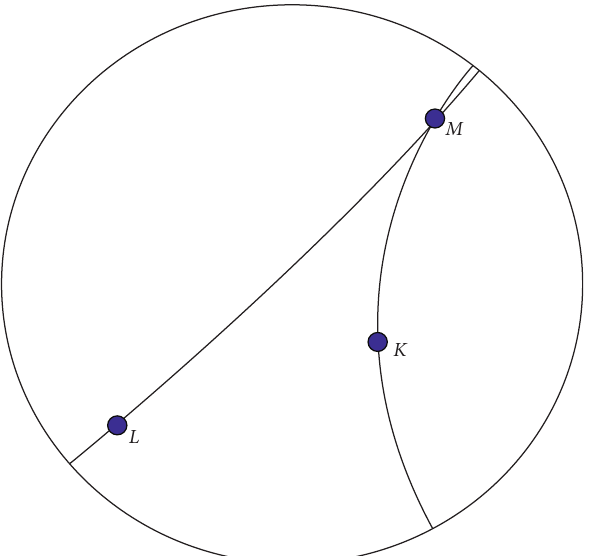
Figure 1: A gyroline (hyperbolic line) passing through the points M and K is a circular arc that meets the boundary of the disc D orthogonally. The hyperbolic lines passing through the center of disc are also corresponding to chords of the